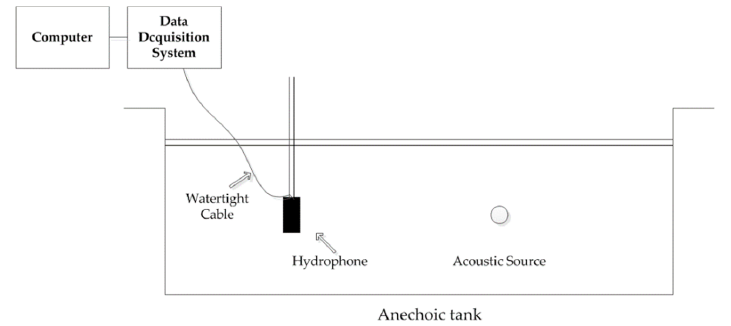
Figure 14. The schematic diagram of experiment.